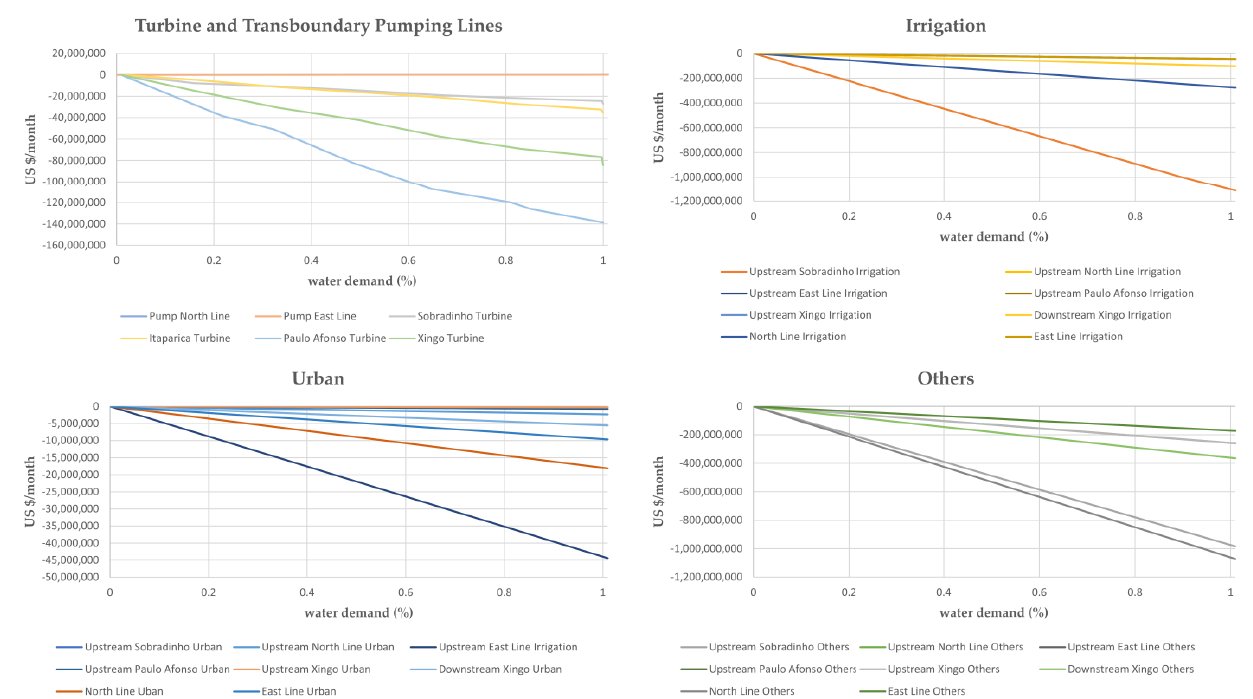
Figure 7. Revenue of each water demand sector and region in the application of the model (an alternative representation of the revenue curves is presented in the Supplementary Materials).